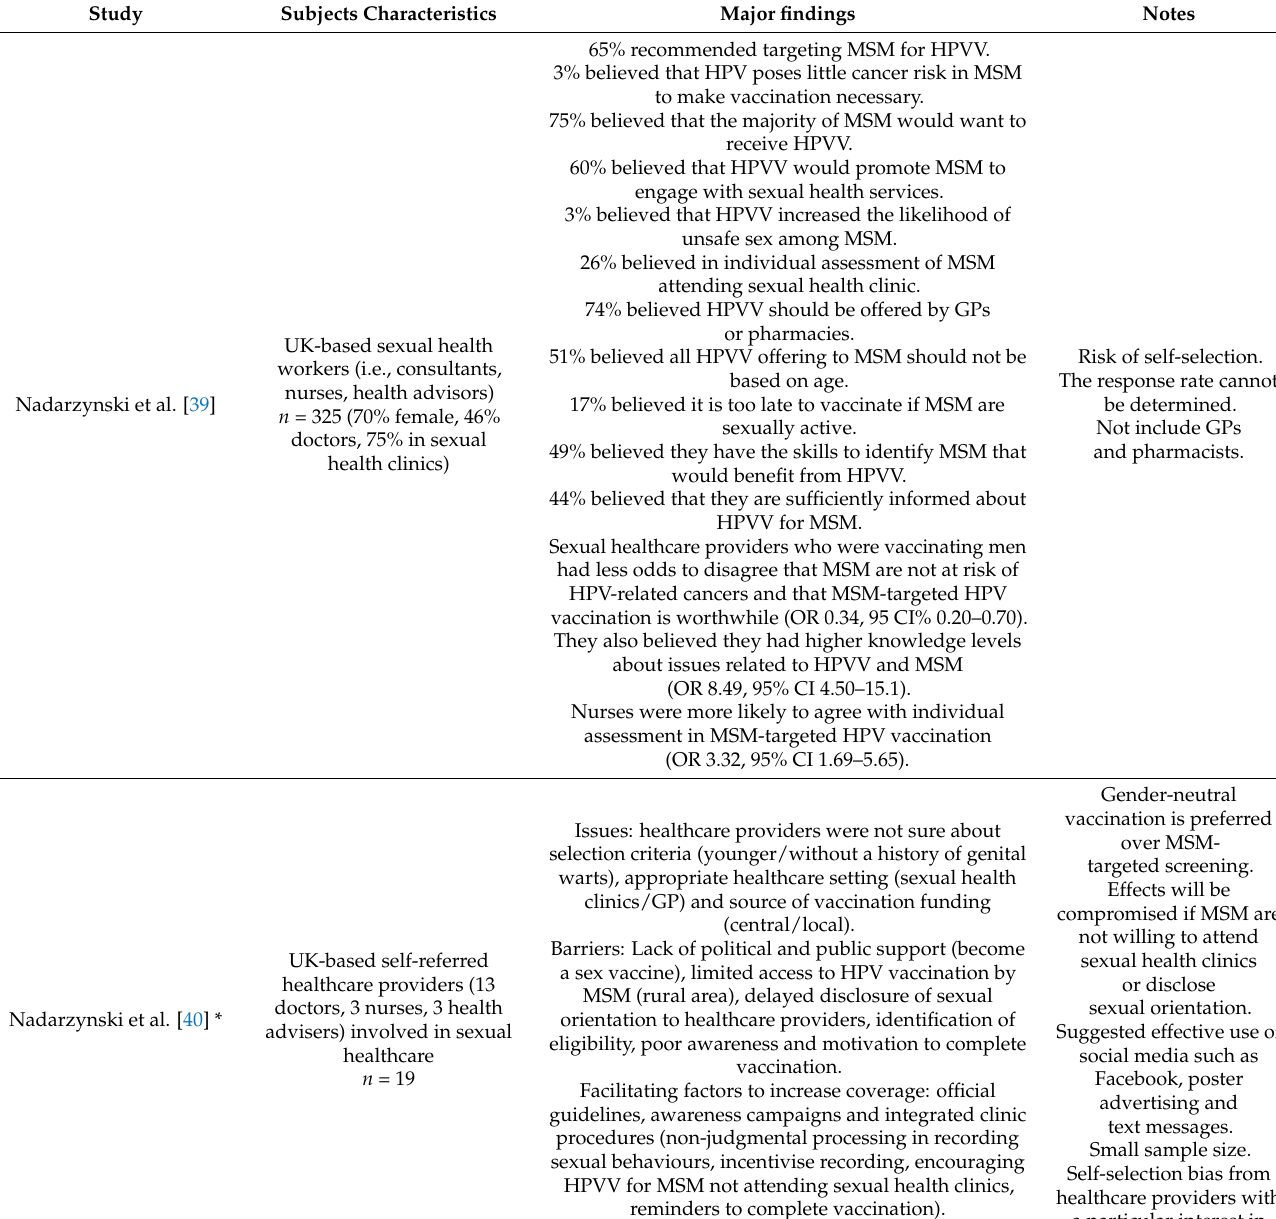
Table 2. Knowledge, beliefs and practices of healthcare providers in providing